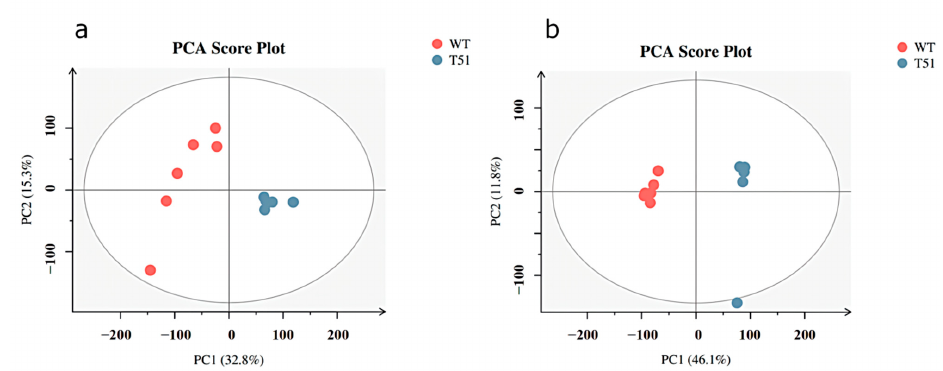
Figure 1. PCA scores plot between WT and T51 in positive and negative ion modes. Note: ( a ) positive ion mode; ( b ) negative ion mode.